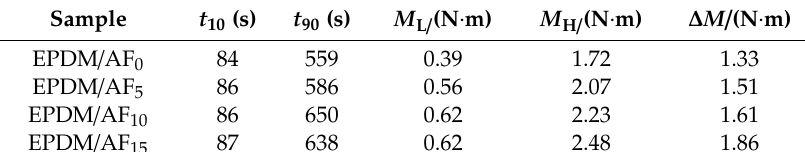
Table 3. Curing characteristics of ceramifiable EPDM composites at 180 ◦ C.